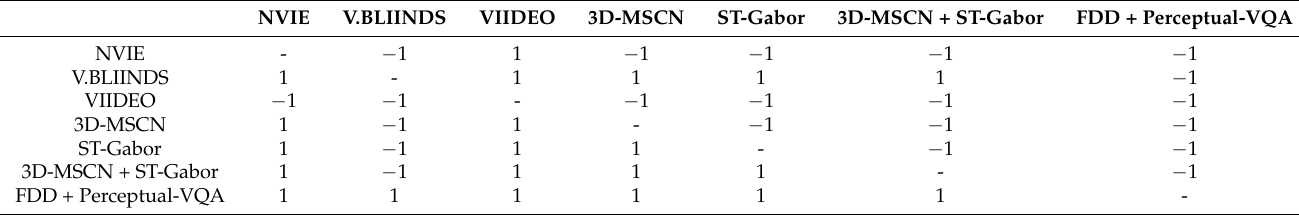
Table 14. A one-sided t -test was carried among 1000 SROCC values measured on KoNViD-1k [22] using a 95% confidence level. In this table, “1” (“ − 1”) denotes that the row algorithm is statistically better (worse) than the column algorithm.